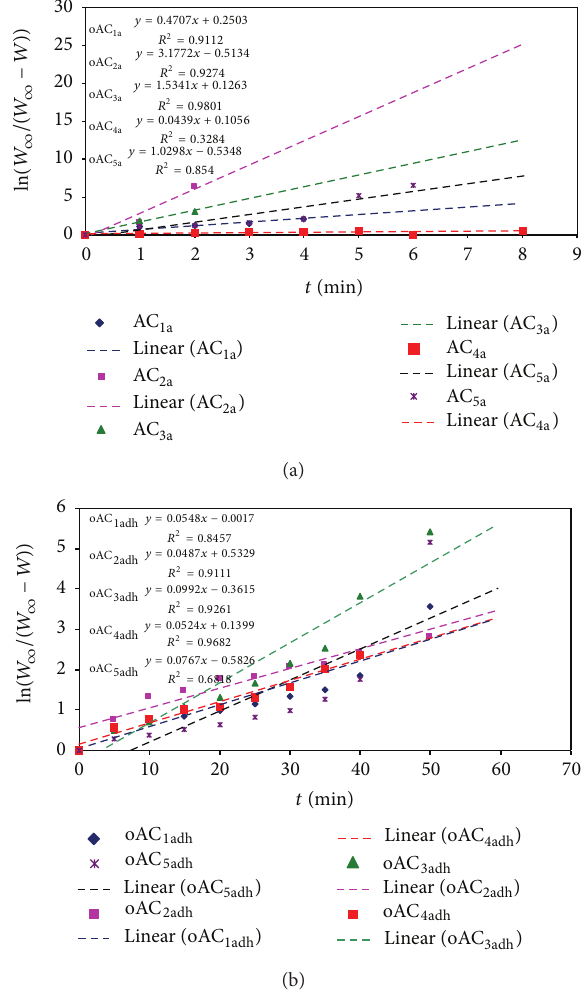
Figure 5: Plot of ln (𝑊 ∞ /(𝑊 ∞ − 𝑊 𝑡 )) against time according to (4) (first order kinetics) for the calcium cross-linked (AC 1a –AC 5a ) (a) and covalently cross-linked alginate/k-carrageenan hydrogel formulations (oAC 1adh –oAC 5adh )